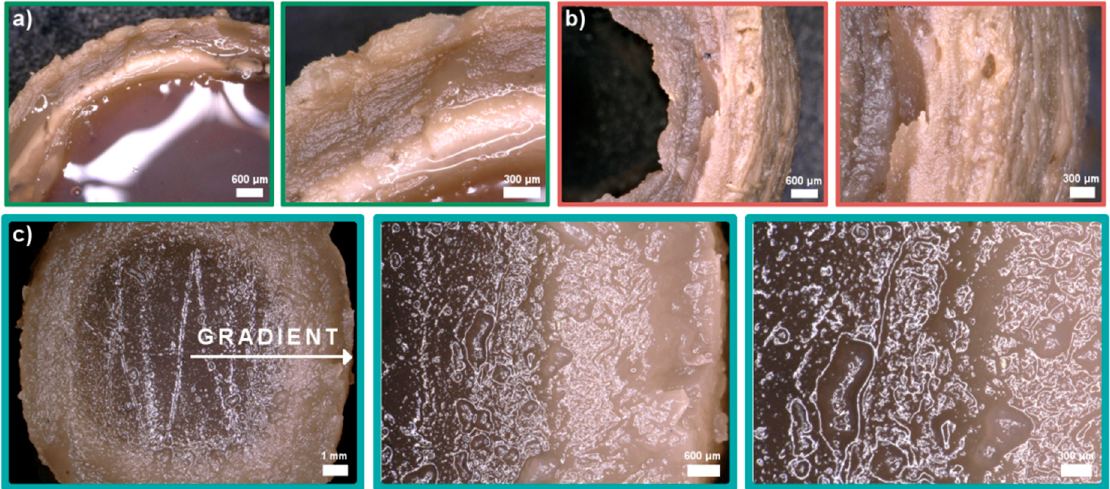
Figure 4. Digital microphotographs of chitosan / graphene oxide (H1) hydrogels obtained in three types of cross-linking solutions: ( a ) 5% TPP (sodium tripolyphosphate), 2 h + 10% NaOH, 10 min, ( b ) 5% TPP, 4 h + 10% NaOH, 10 min, ( c ) 0.5% TPP with 5% NaCl, 24h.